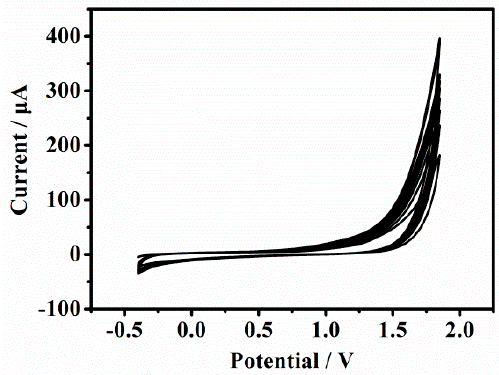
Figure 1. CVs of the electrochemical polymerization of p-Gly/rGO at GCE.